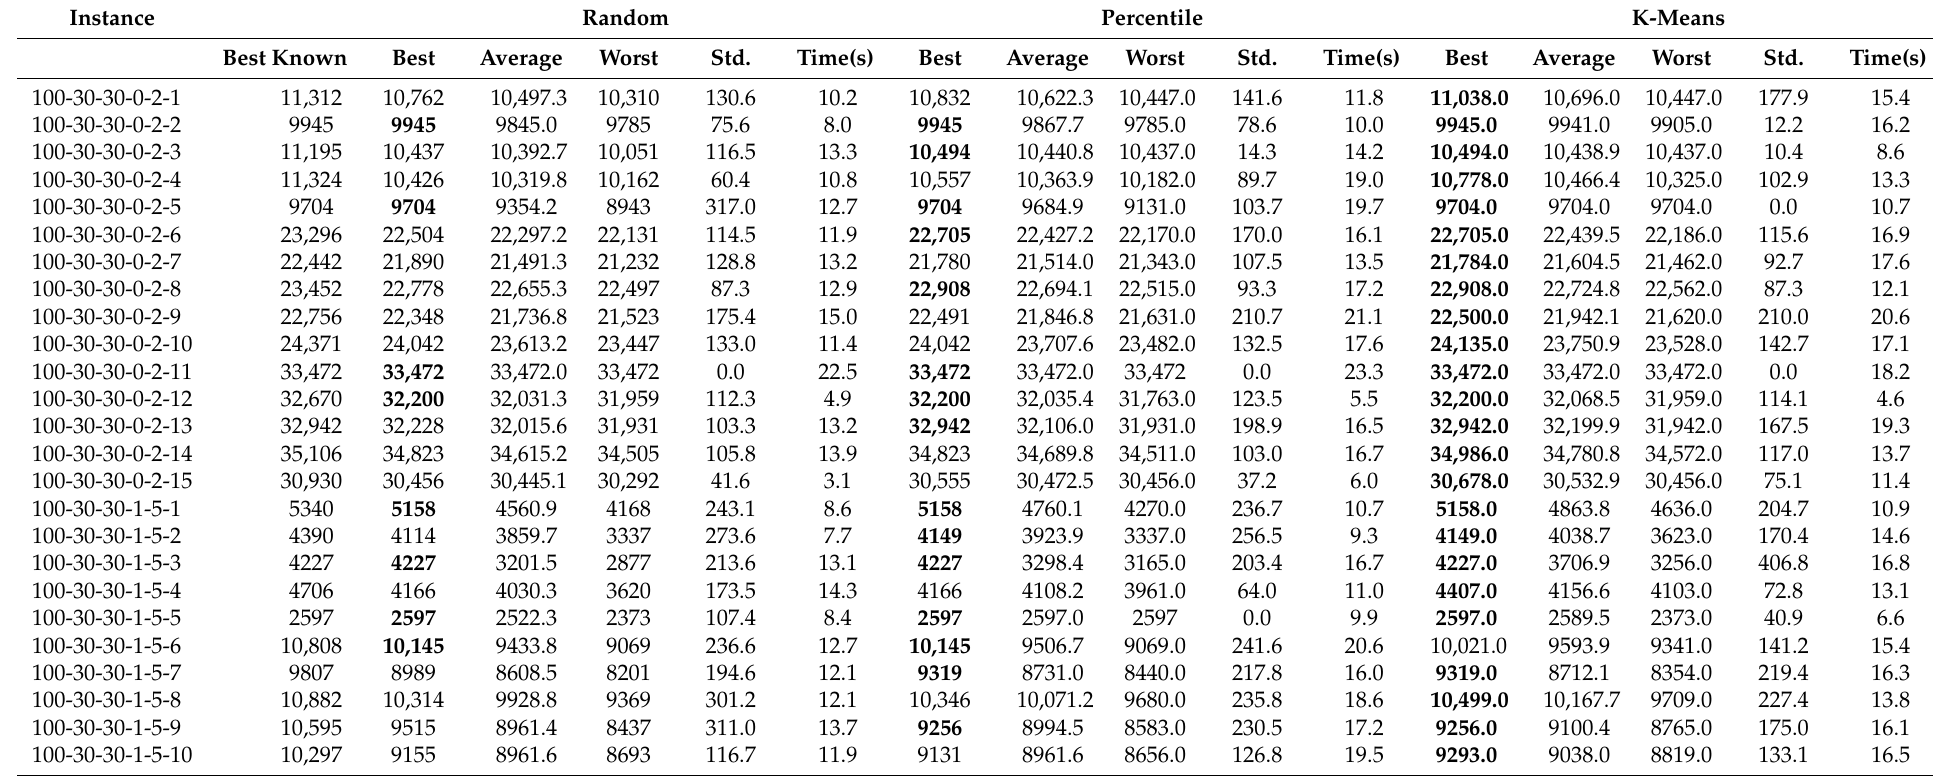
Table 4. Comparison between Random, Percentile and K-means binarization methods for 100-30-30 instances and sine-cosine